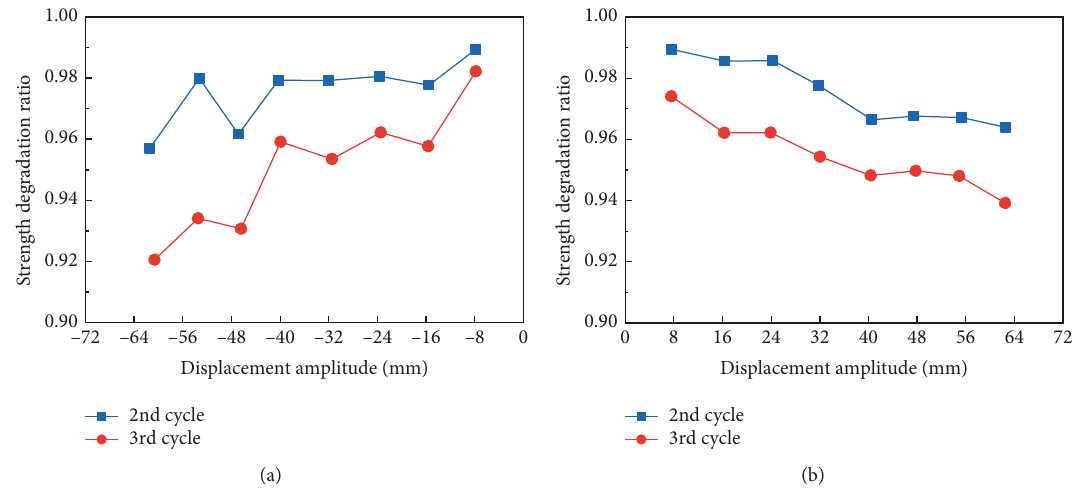
Figure 13: Strength degradation vs. displacement amplitude curve. (a) Negative loading. (b) Positive loading.